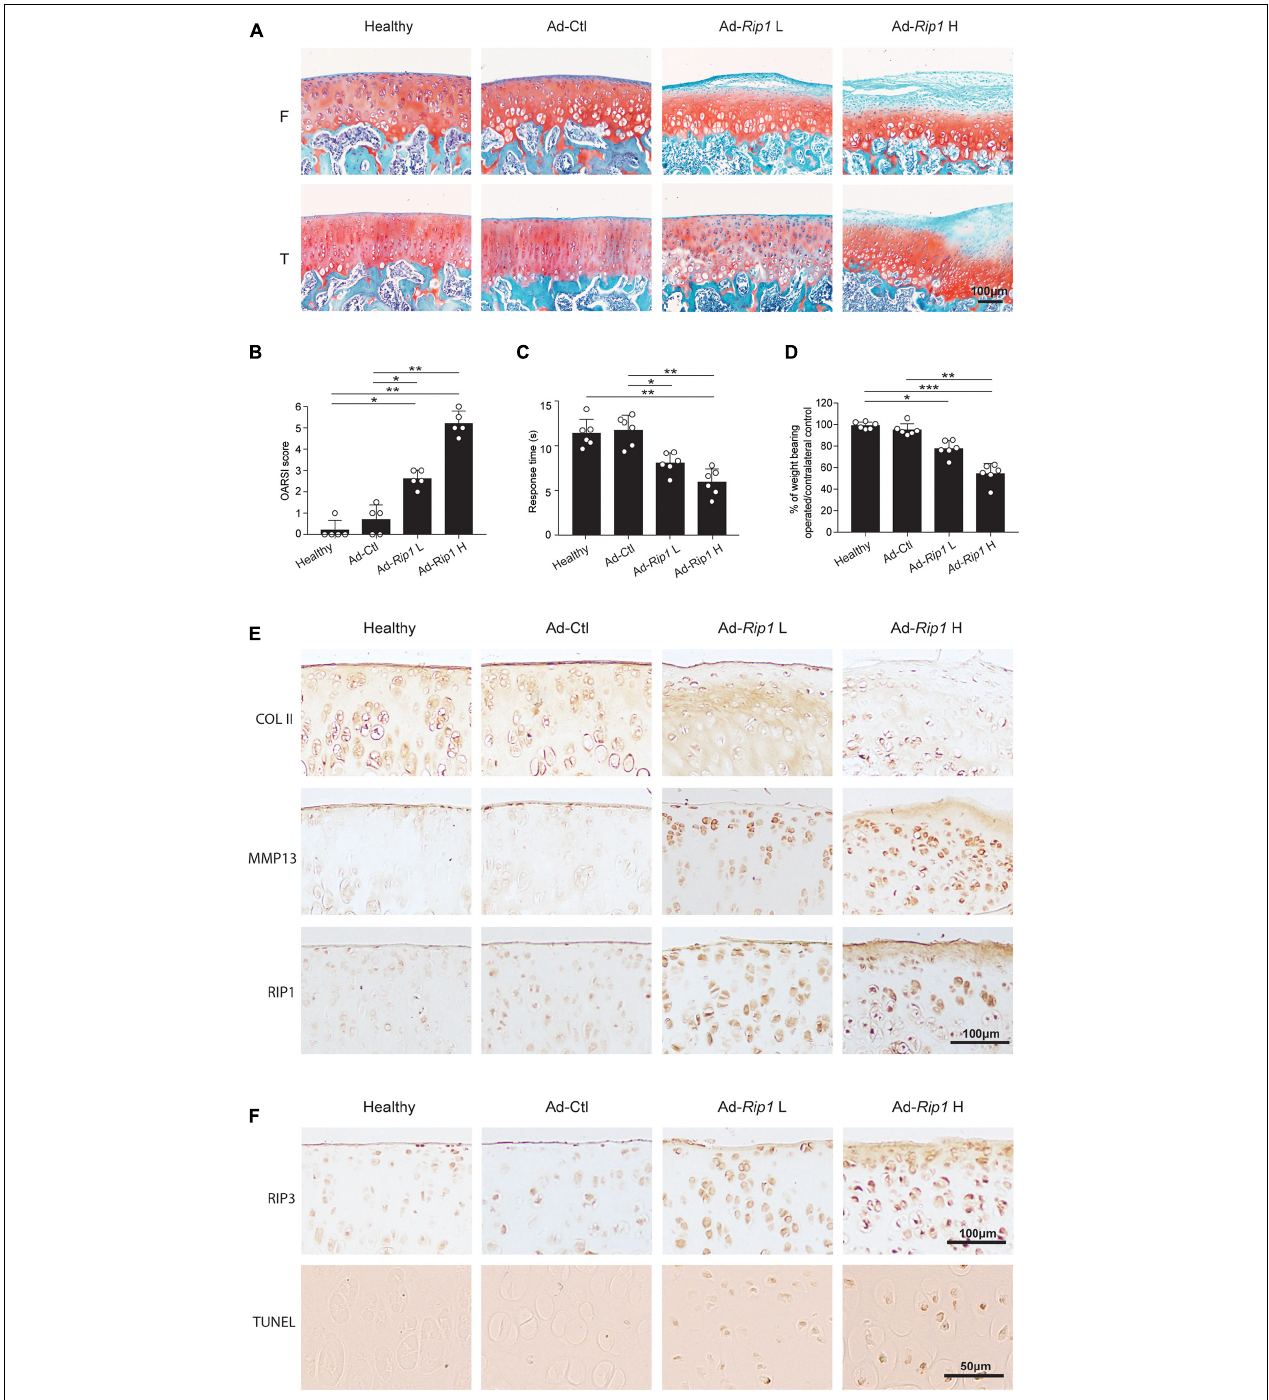
FIGURE 5 | Intra-articular overexpression of RIP1 induces OA-related symptoms in rats. (A,B) Safranin O and fast green staining (A) and the corresponding OARSI scores (B) of the cartilage from rats intra-articularly injected with Ad-Ctl (5 × 10 8 pfu) and two different doses of Ad- Rip1 (10 8 pfu, 5 × 10 8 pfu) ( n = 5 for each group) F: femur; T: tibia. (C) The pain response times for the rats of each group when placed on the 55 ◦ C hotplate meter ( n = 6 for each group). (D) The ratios of weight placed on the hindlimb with adenovirus injection vs. that on the contralateral sham hindlimb for the rats of each group ( n = 6 for each group). (E) COL II, MMP13, and RIP1 immunostaining of the cartilage from rats intra-articularly injected with Ad-Ctl (5 × 10 8 pfu) and two different doses of Ad- Rip1 (10 8 pfu, 5 × 10 8 pfu) ( n = 5 for each group). (F) RIP3 immunostaining and TUNEL staining of the cartilage from rats intra-articularly injected with Ad-Ctl (5 × 10 8 pfu) and two different doses of Ad- Rip1 (108 pfu, 5 × 108 pfu) ( n = 5 for each group). * P < 0.05, ** P < 0.01, and *** P < 0.001.